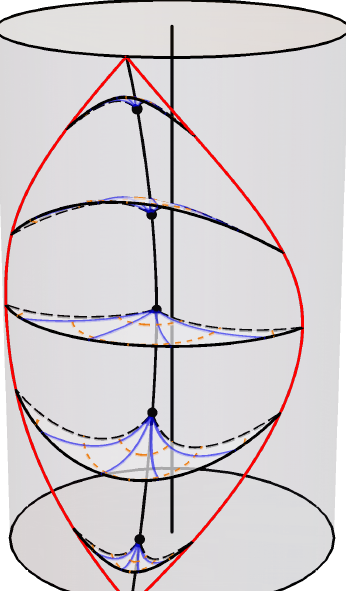
JHEP05(2022)063